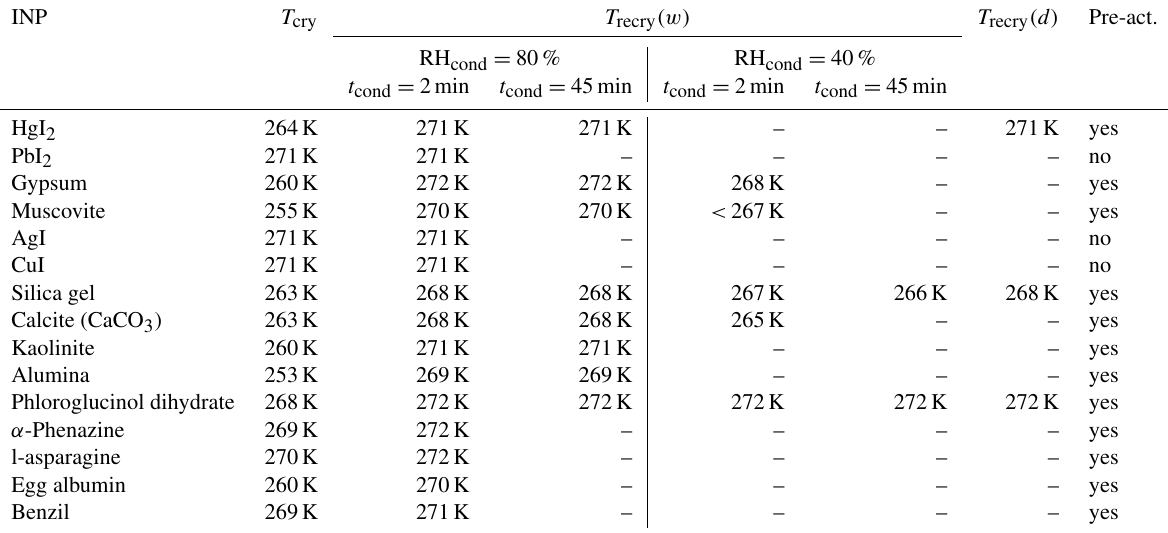
Table 7. Particles deposited on hydrophobic glass cover slips investigated by Edwards and Evans (1971). T cry – crystallization temperature to obtain a nucleated fraction of F = 10 − 3 after 5min at RH w = 120%. T recry (w) – recrystallization temperature to obtain a nucleated fraction of F = 10 − 3 after 5min at RH w = 120% after activation at RH w = 120% and T = 243K followed by drying at RH cond with respect to ice for a time t cond ; T recry (d) – recrystallization temperature to obtain a nucleated fraction of F = 10 − 3 after 5min at RH w = 120% after activation at RH w = 80% and T = 243K.